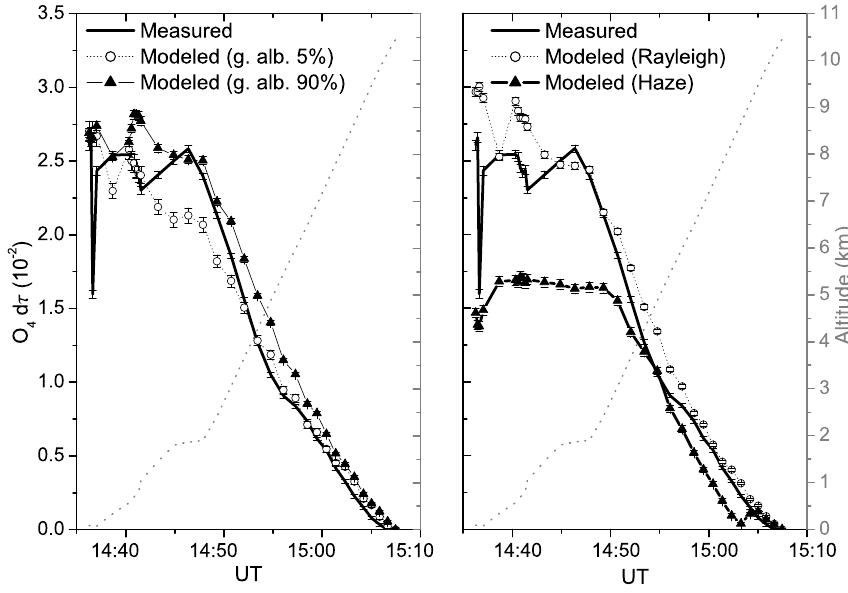
Fig. 3. Influence of forward parameters in the RT model of a known trace gas ( O 4 ). Left: influence of the ground albedo, comparing the forward modeled O 4 dτ if a ground albedo of 5% (ocean) and 90% (snow) are considered in the forward RT model. Right: influence of the E M vertical profile, comparing a Rayleigh atmosphere with a rather strong haze situation ( E M =0 . 1 km − 1 ) throughout the whole troposphere (79% ground albedo).